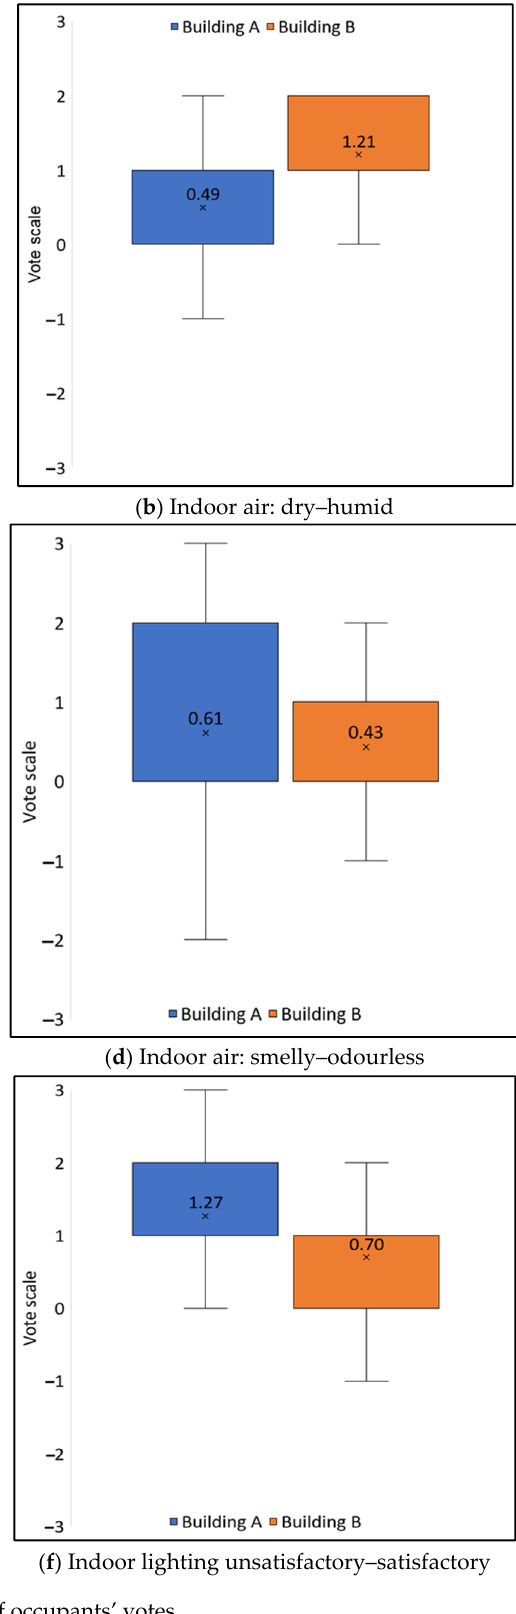
Figure 8. Distribution of occupants’